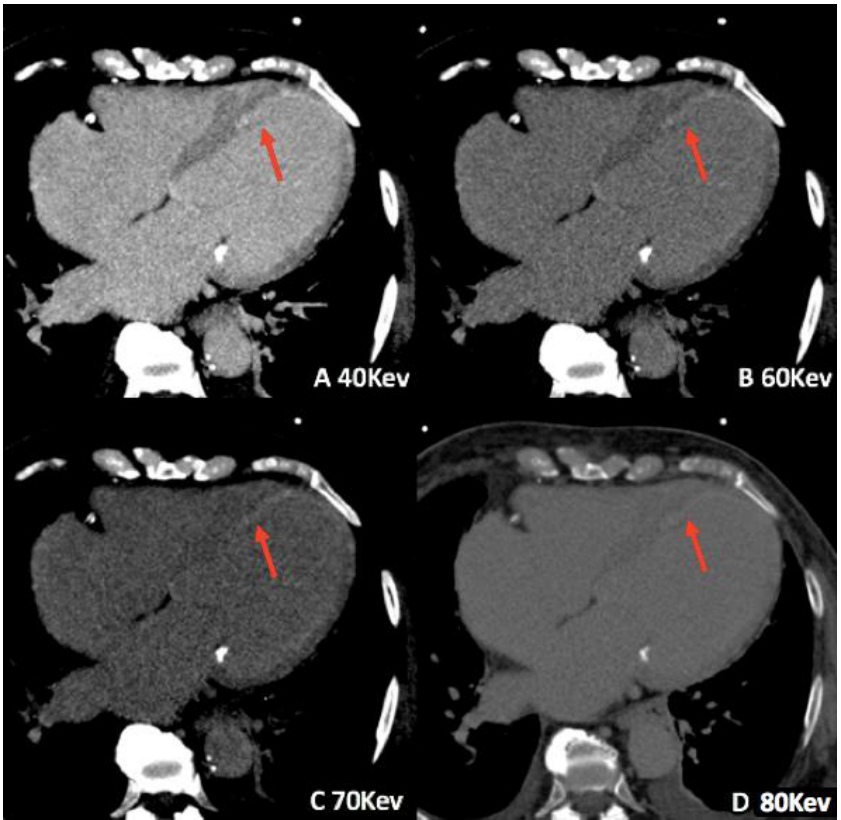
Figure 2. Late iodine enhancement dual-source DECT images in a 72-year-old man. Sub-endocardial hyperenhancement (red arrows) can be seen in the left ventricular septal wall and apex at different virtual monochromatic image values ( A – D ).